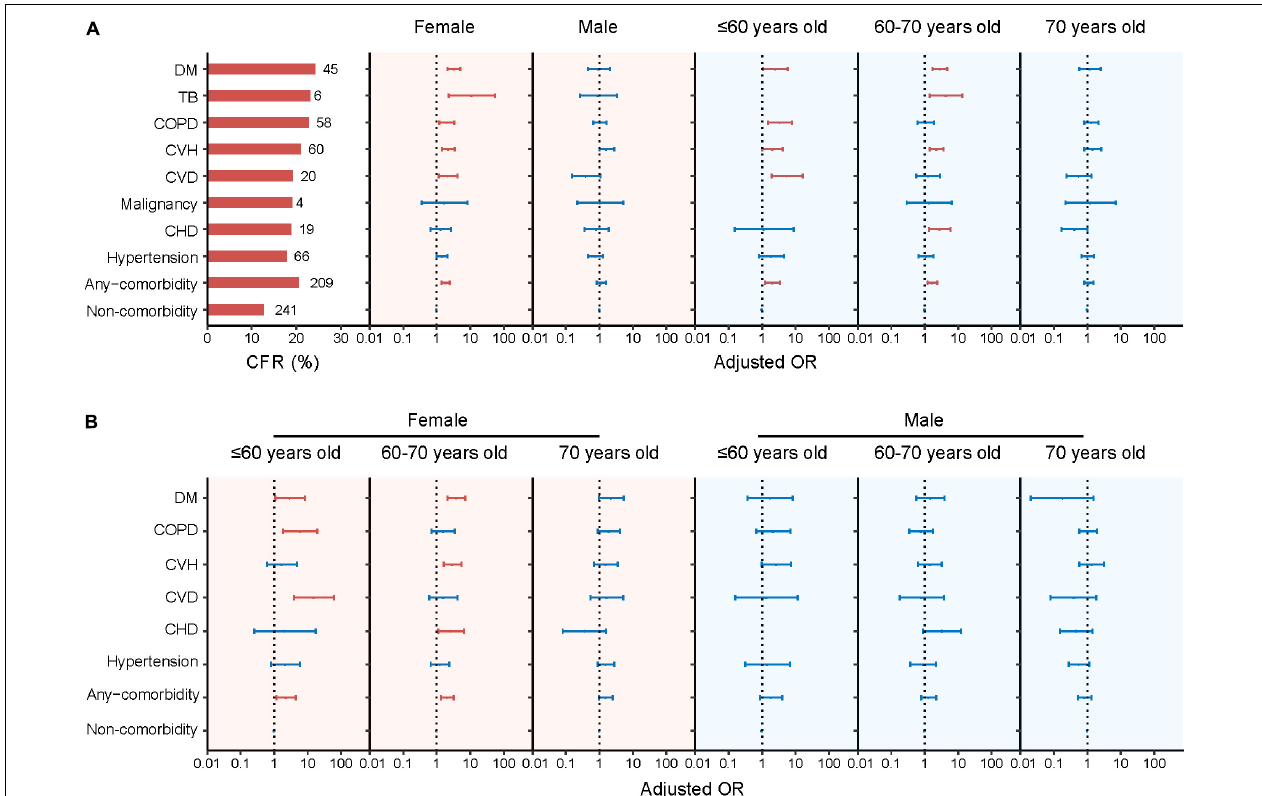
FIGURE 2 | Presence of comorbidity and risk for fatal outcome of SFTS patients stratified by sex or age (A) and further stratified by both sex and age (B) . The numbers of deaths and CFRs of the SFTS patients with single comorbidity were shown to the left of column in panel (A) . Multivariate logistic regression model was performed for association between comorbidity and fatality by adjusting age, sex, and delay between disease onset and hospital admission. Adjusted ORs (aORs) and 95% CIs were presented for each comorbidity. The dots are the aORs and the error bars are the 95% CIs. The red color represents P < 0.05 and the blue color represents P ≥ 0.05. The dotted line indicates an OR of 1. DM, diabetes mellitus; TB, Pulmonary tuberculosis; COPD, chronic obstructive pulmonary diseases; CVH, chronic viral hepatitis; CVD, cerebrovascular diseases; CHD, chronic heart